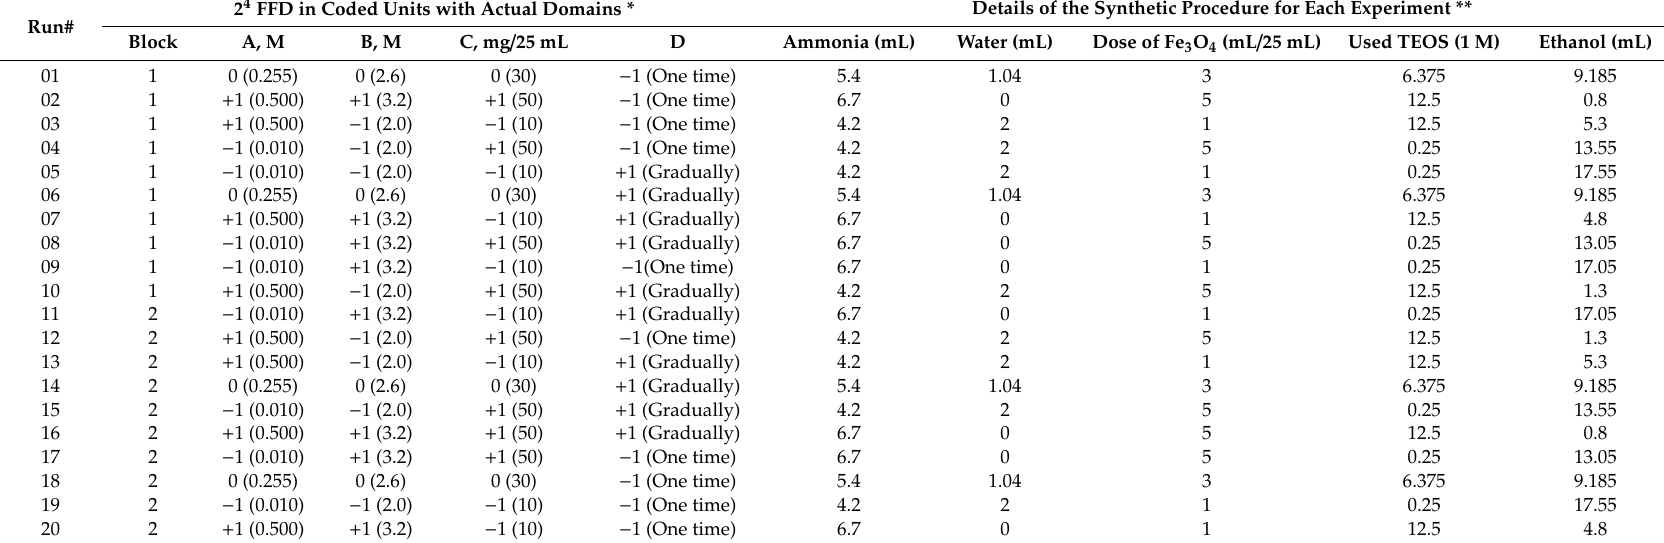
Table 2. Randomized design matrix for the 2 4 full factorial design for coded variables. Real levels are given beside each domain code. Details of the synthetic procedure are also